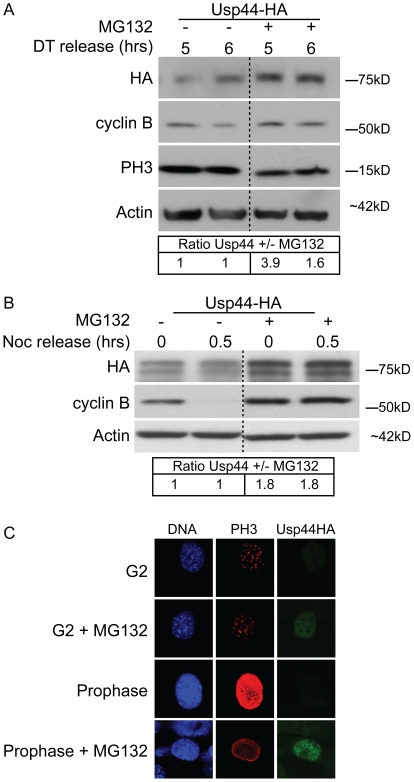
Usp44 is degraded by the proteasome.(a, b) Immunoblots of MEFs synchronized either by double-thymidine block (a) or mitotic shake-off (b), expressing Usp44-HA. Cells were incubated with MG132 3 hours after double-thymidine release or one hour prior to mitotic shake off. Relative quantitation was performed using imageJ. (c) Immunofluorescence images of cells expressing Usp44-HA treated (where indicated) with MG132 one hour prior to fixation.